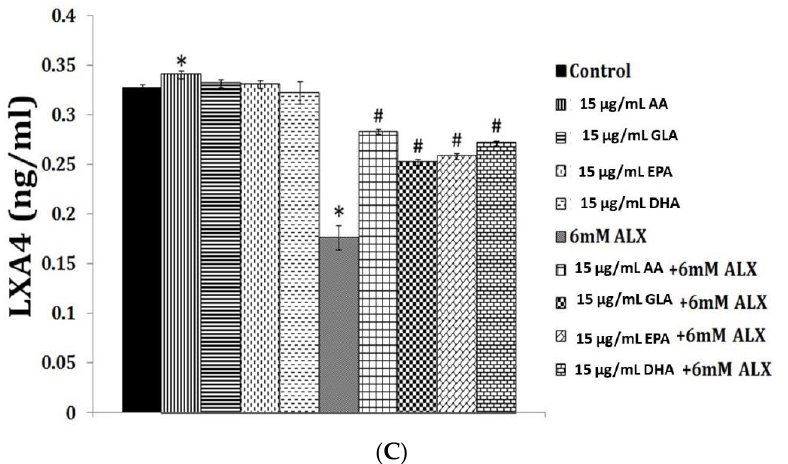
Figure 4. Effect of various polyunsaturated fatty acids (PUFAs) on LXA4 secretion by RIN cells (rat insulinoma cells) treated with alloxan and streptozotocin. Alloxan and streptozotocin-induced inhibition of LXA4 secretion by RIN cells is restored to near normal by GLA, AA, EPA and DHA compared to control. ( A ) RIN5F cells were treated with various doses (1, 2, 4, 6 mM) of alloxan for 1, 2, 4 h. The LXA4 was estimated by ELISA in the supernatant of cultures. ( B ) RIN5F cells were treated with 10 μg/mL GLA, AA, EPA and DHA and alloxan (6 mM) for 1 h. Streptozotocin (21 mM) treated RIN cells (for 24 h) were exposed to 10 μg/mL of various PUFAs ( C ). The LXA4 was estimated in the supernatant of the cell cultures. * p < 0.05 compared to untreated control, # p < 0.05 compared to alloxan, compared to STZ. It is seen that at 10 μg/mL dose of EPA and DHA treat- ment there is no increase in LXA4 secretion by RIN5F cells in vitro in the presence of alloxan (6 mM) (Figure 4A). However, when RIN5F cells were supplemented with 15 μg/mL of EPA and DHA there is a significant increase LXA4 secretion even in the presence of alloxan (Figure 4B). In contrast 10 μg/mL of PUFAs could increase LXA4 secretion to near normal by RIN cells (Figure 4C) (AA > GLA > EPA > DHA). It is seen from this data that GLA, EPA and DHA can augment LXA4 formation but are less potent compared to AA. This suggests that some of the anti-inflam- matory actions of GLA, EPA and DHA could be due to their action to enhance LXA4 formation in addition to their ability to give rise to PGE1 (from GLA); resolvins of E series from EPA and re- solvins of D series, protectins and maresins from DHA. This data is taken from references [35,36].